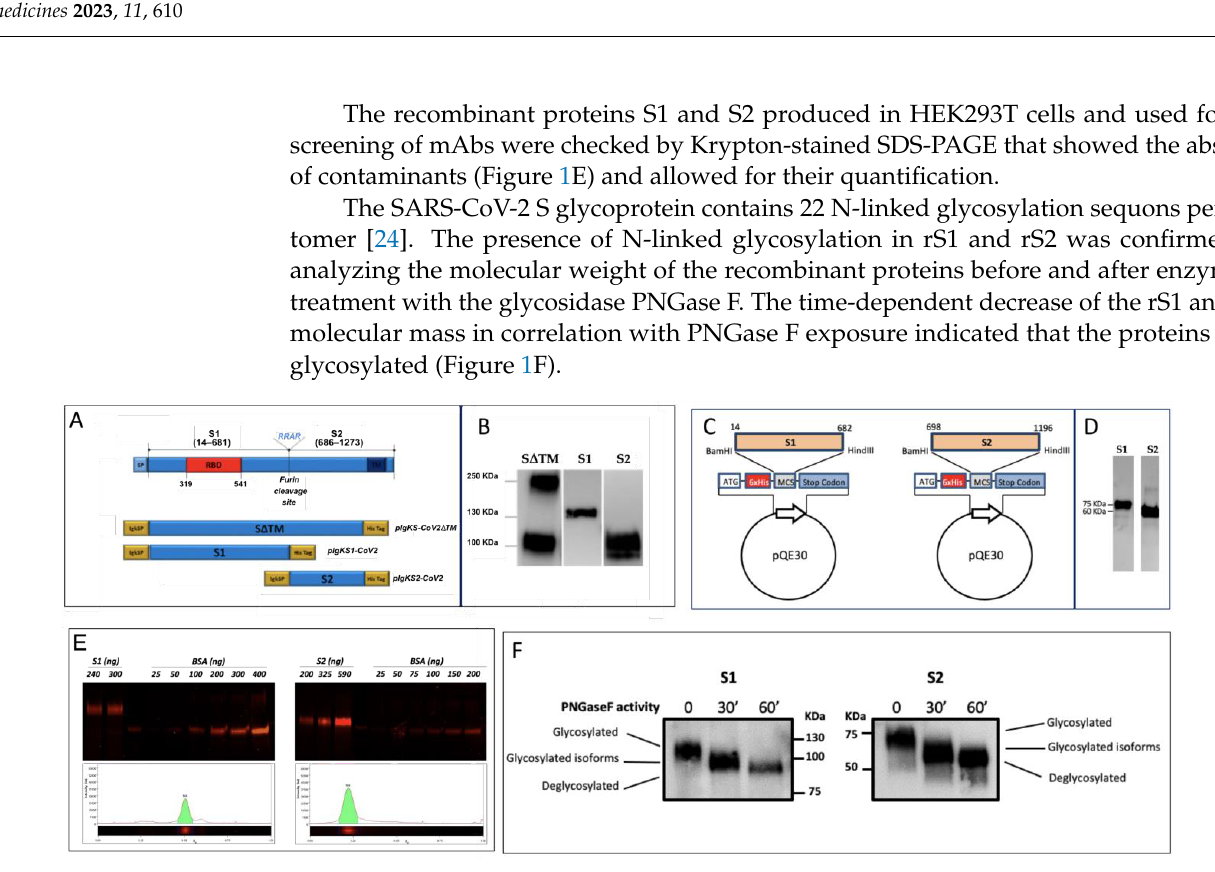
Figure 1. SARS-CoV-2 S recombinant proteins. ( A ) In the top diagram, the full-length SARS-CoV-2 S protein is depicted. SP, signal peptide; S1, subunit 1; S2, subunit 2; RBD, receptor-binding domain; TM, transmembrane domain. On the bottom, the diagram of the three different spike regions is shown, expressed by the generated plasmids: pIgkS16–1182 ∆ TM; pIgKS116–682; and pIgKS2685–1182. IgK SP: immunoglobulin kappa light chain signal peptide; His Tag: polyhistidine tag (6xHis). ( B ) WB analysis for the detection, using an anti-His tag, of the S ectodomain soluble form (S ∆ TM) and the recombinant S1 and S2 domains in the supernatants of transfected HEK293T cells. Strips of three different WBs are shown. ( C ) Schematic representation of S1 and S2 constructs in the E. coli expression vector. ( D ) The identities of proteins were confirmed by WB using the polyclonal anti-S SARS-CoV-2. ( E ) Upper: increasing quantities of rS1 or rS2 and known concentrations of BSA were resolved on SDS-PAGE, and quantification was achieved using Krypton fluorescent protein stain. Bottom: the electrophoretic profiles of recombinant proteins are reported. Lane 2 from both gels was selected as the representative of rS1 or rS2: the presence of a unique peak for both proteins indicates the absence of contaminants. ( F ) Purified rS1 and rS2 were denatured and digested with PNGase F for 30 and 60 min. The positions of glycosylated and deglycosylated proteins are indicated. A representative experiment of three is